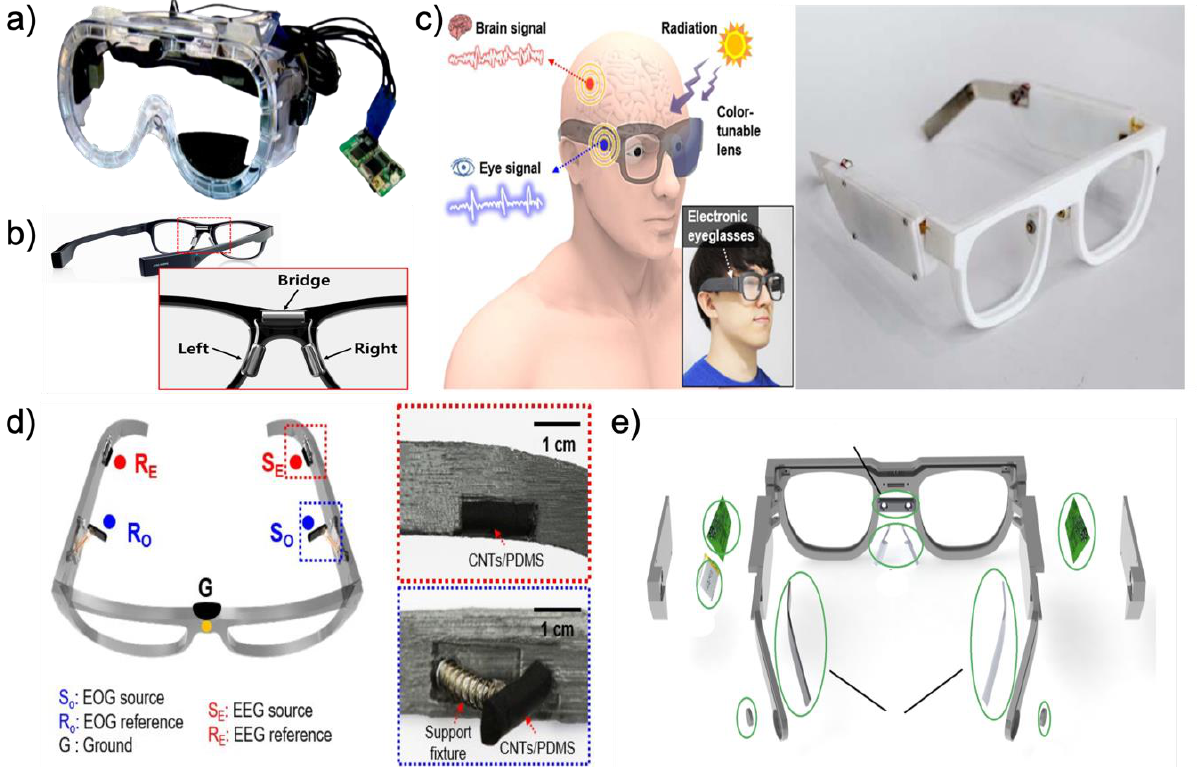
Figure 5. Examples of eyeglasses with electrodes. ( a ) Goggle type of EOG device (reprinted with